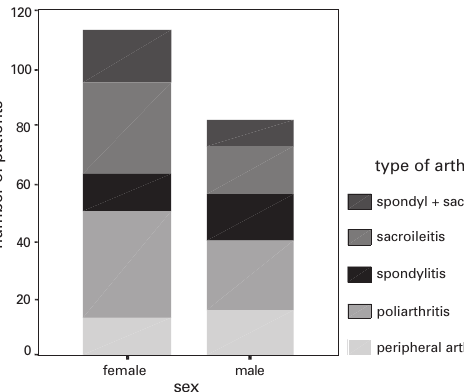
Types of arthritis in 195 patients with musculoskeletal involvement accord- ing to